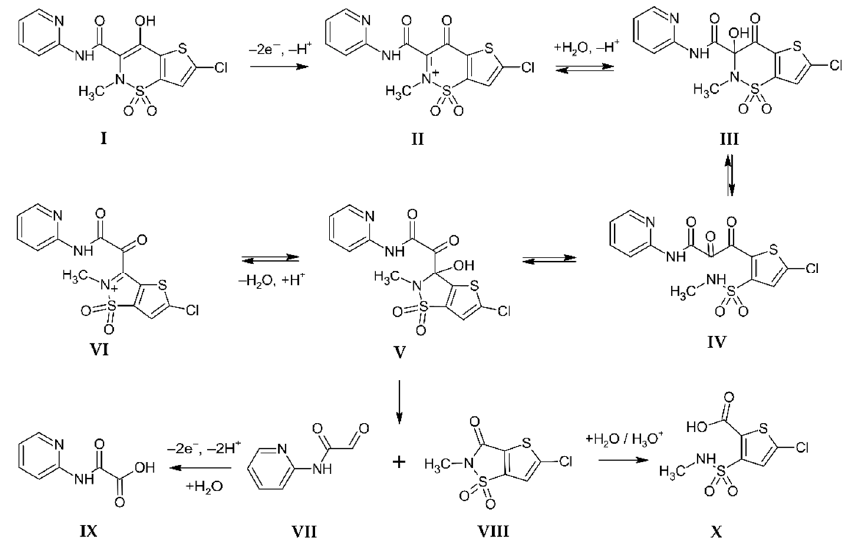
Scheme 4. Proposed mechanism of electrochemical oxidation of LRX.